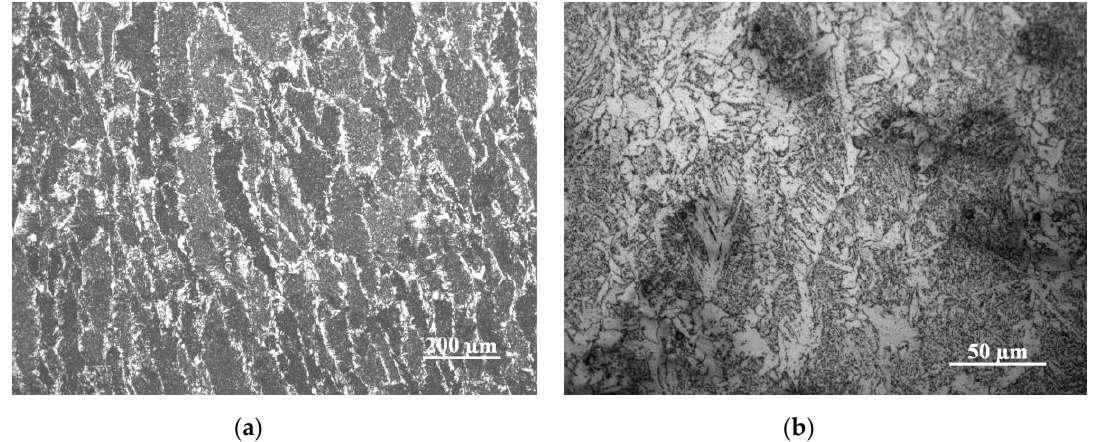
Figure 3. Microstructure of weld: ( a ) columnar grains enclosed by ferrite; ( b ) lamella ferrite and featherlike widmanstatten structure.